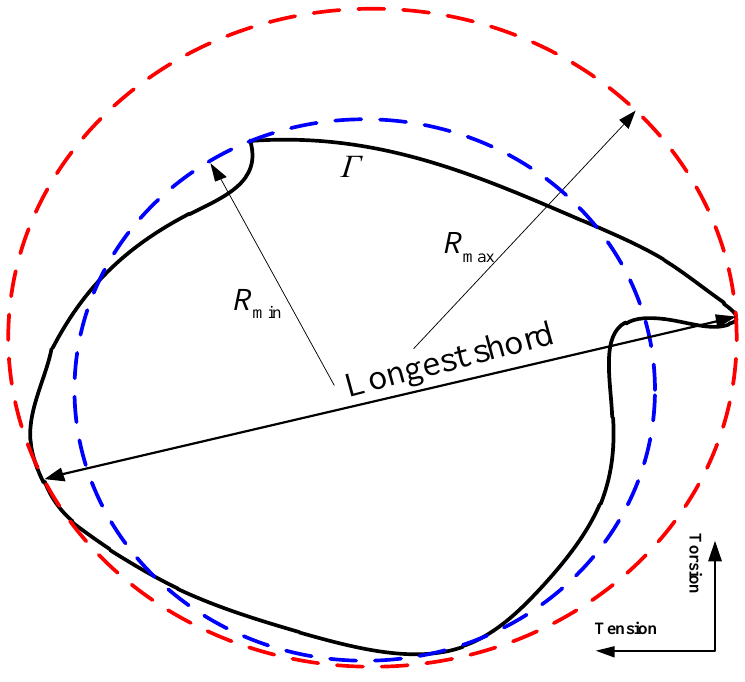
Figure 2. Assumption of multiaxial loading state.